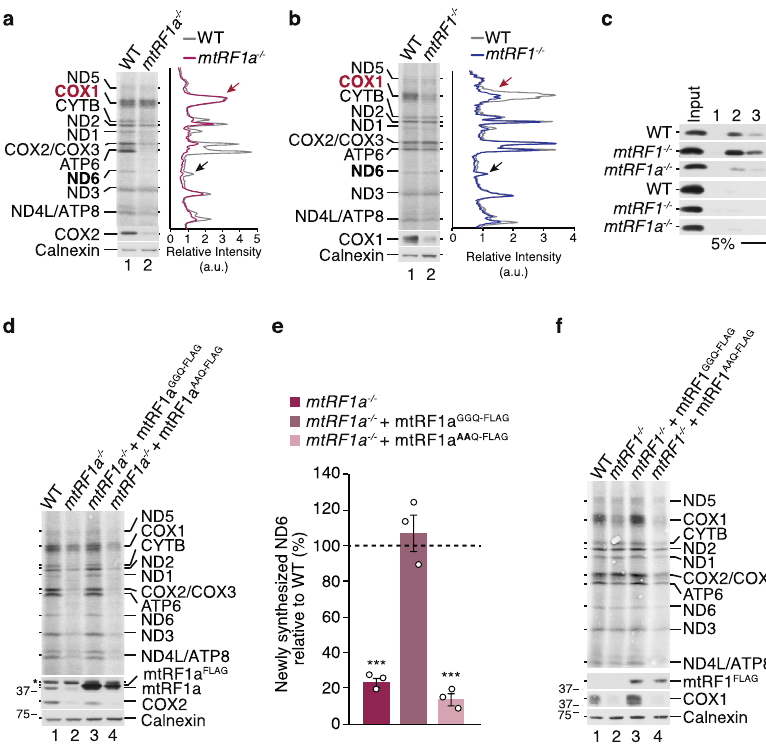
Fig.3|MitochondrialtranslationrequiresmtRF1andmtRF1a.a , b Thesynthesis of mtDNA-encoded proteins was analyzed by [ 35 S]Methionine de novo